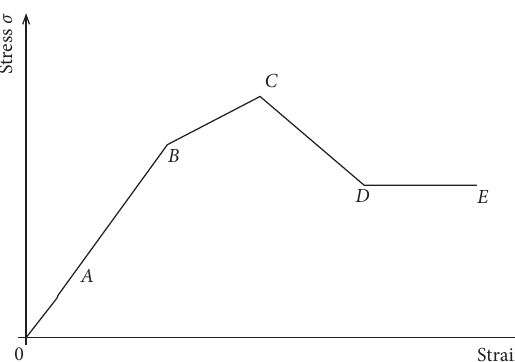
Figure 7: Simplified model of constitutive relation under triaxial